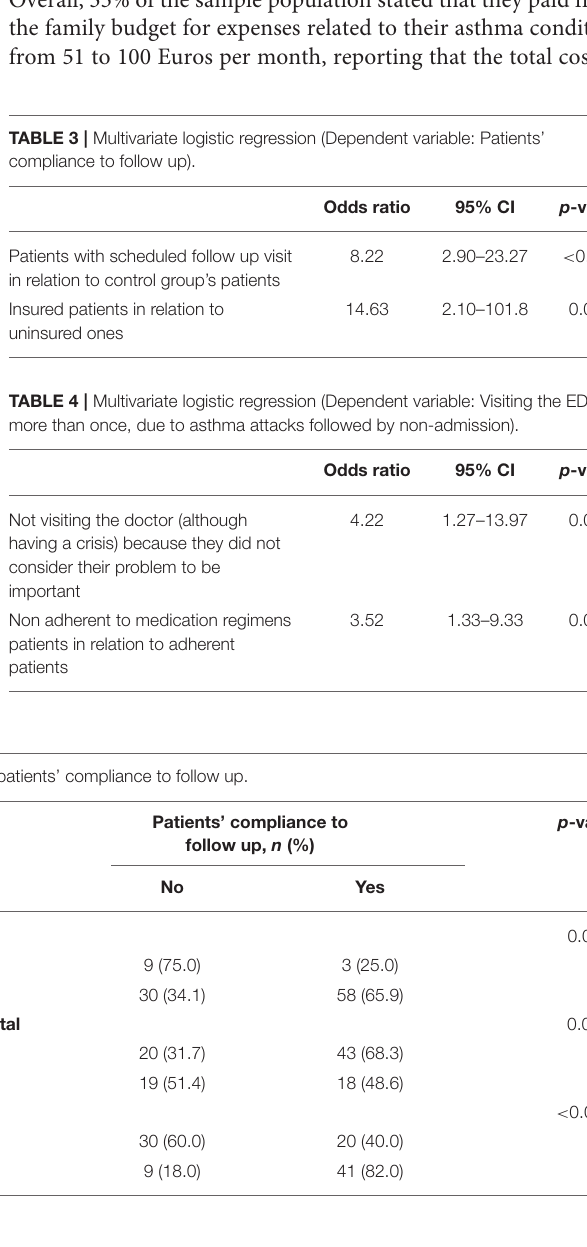
TABLE 3 | Multivariate logistic regression (Dependent variable: Patients’ compliance to follow up).